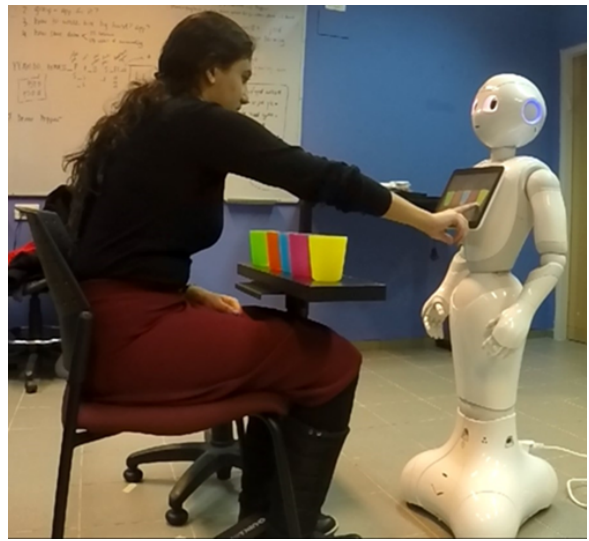
Figure 2: In order to indicate completion of the task the participant is touching the robot’s